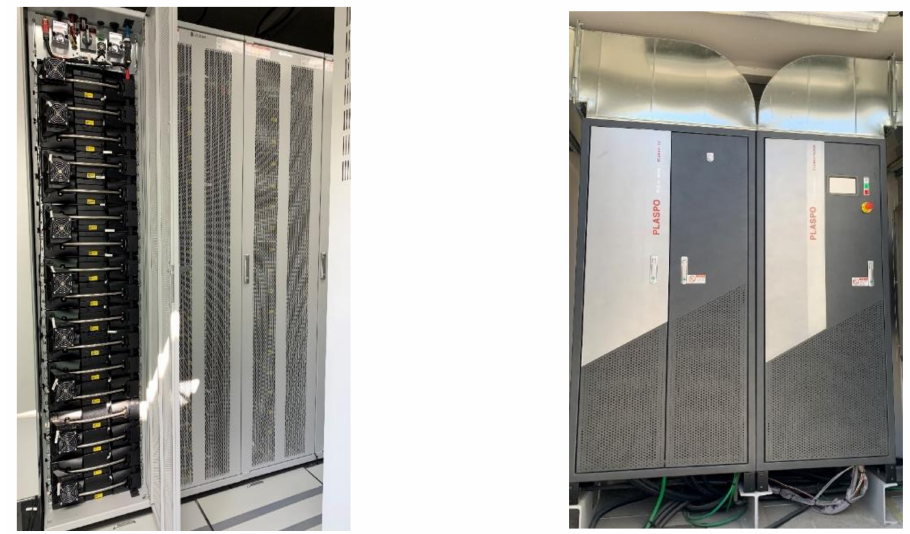
Figure 5. Energy storage system under field operation: battery racks ( left ), inverter and transformer ( right ).